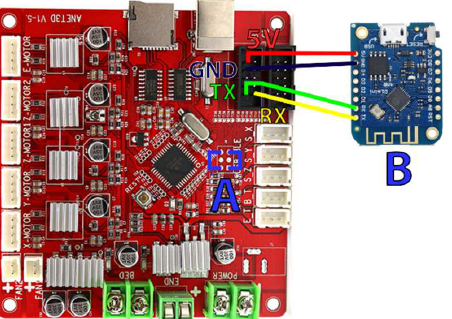
Figure 2. Modification of the Anet A8 motherboard. This modification allows driving the 3D printer